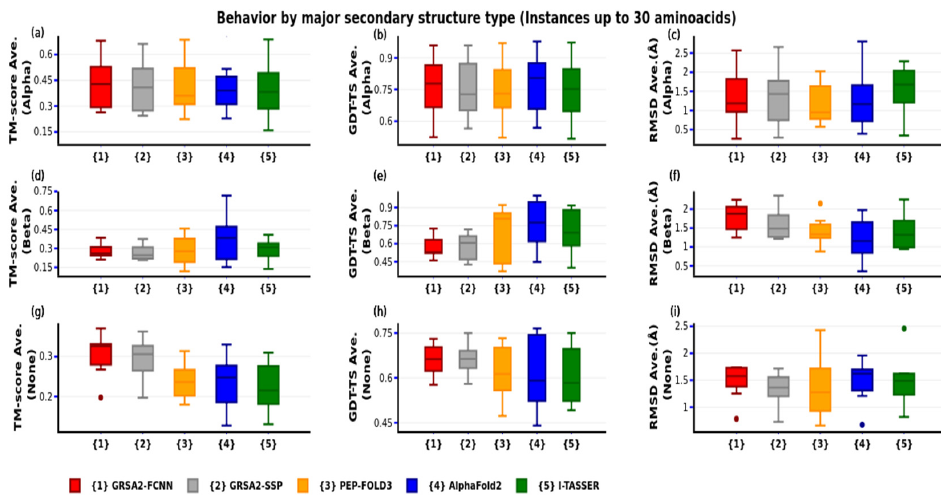
Figure 10. Comparison by major secondary structure type of GRSA2-FCNN versus AlphaFold2, I-TASSER, PEP-FOLD3, and GRSA2-SSP with TM-score and GDT-TS. ( a , d , g ) show the set of type Alpha, Beta, and None evaluated with TM-score (average of the five best predictions for each peptide). ( b , e , h ) show GDT-TS for Alpha, Beta, and None. ( c , f , i ) present the RMSD results in Alpha, Beta, and None.